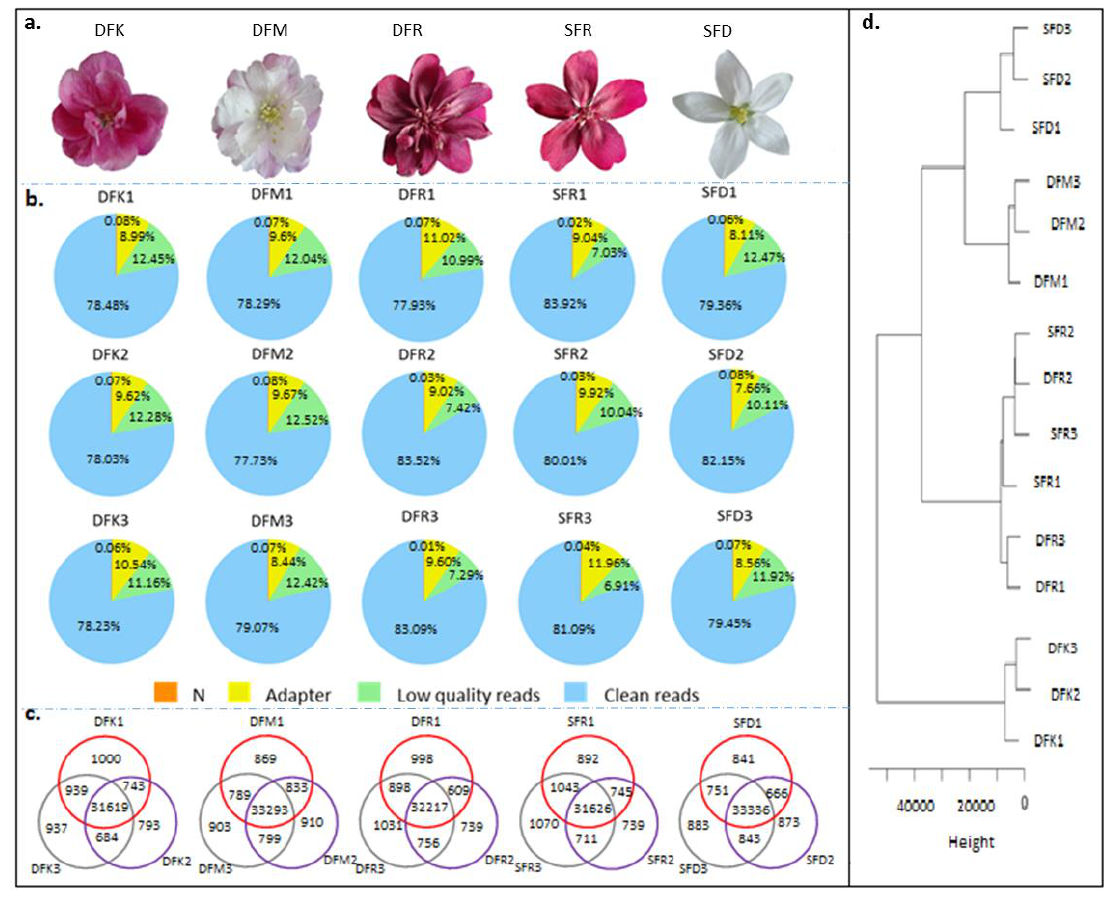
Figure 1. ( a ) Phenotypes of flowers of all the sample species. ( b ) Raw data filtering composition statistics of all five samples replicated three times where; N: Fraction of indistinguishable bases as a function of the base position in the reads; adapter: Ratio of reads containing joint (joint pollution reads) to the total number of raw reads; low quality reads: Reads with a quality value lower than 15 reads accounted for the total base-base ratio; clean reads: Ratio of number of filtered reads to the total raw reads. ( c ) Venn diagram analysis between each sample replica groups for common expressed genes. (d) Hierarchical cluster analysis between samples. The closer a sample to each other, the more